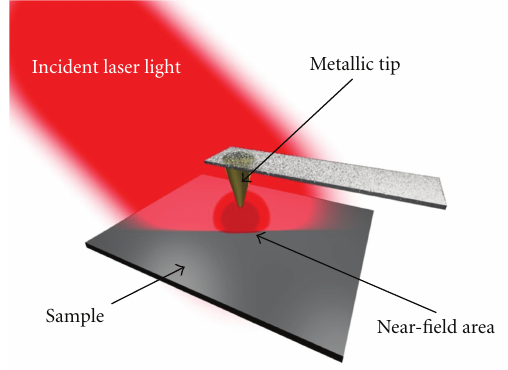
Figure 1: Schematic representation of Tip-Enhanced Raman Spec- troscopy in the side-illumination